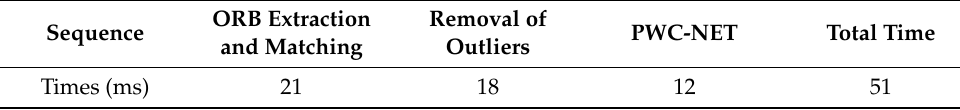
Table 4. The time cost of each module of our system.